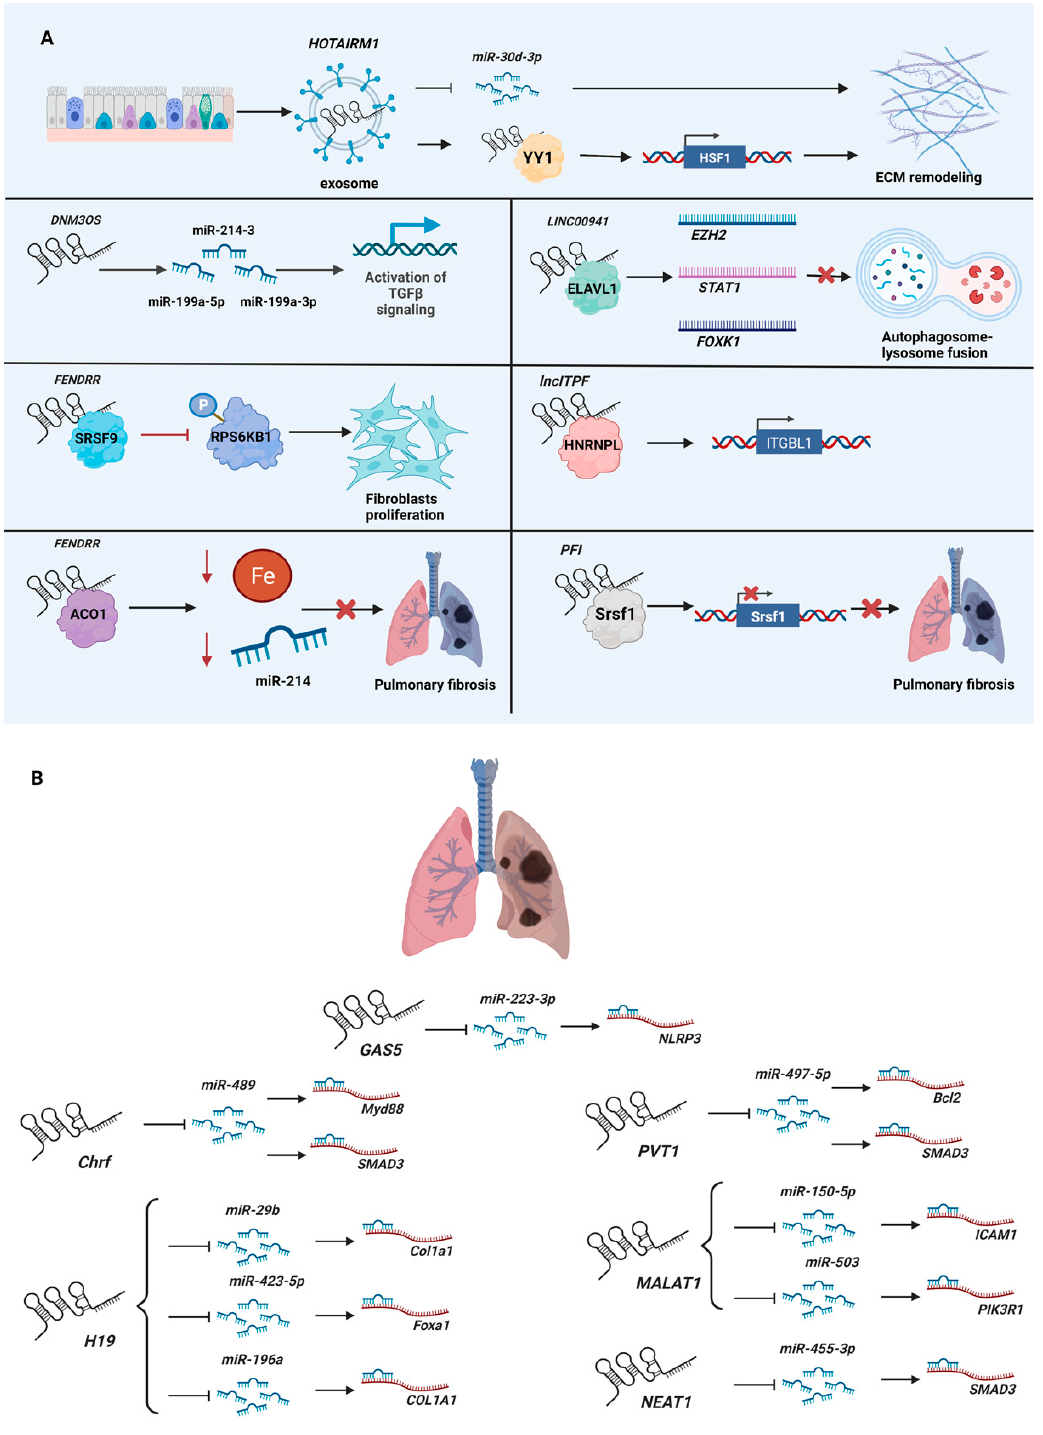
Figure 2. Role of lncRNAs in pulmonary fibrosis: ( A ) Mechanisms of action of lncRNAs in the pathogenesis of pulmonary fibrosis. ( B ) LncRNAs as miRNA sponges for pulmonary fibromiRs.